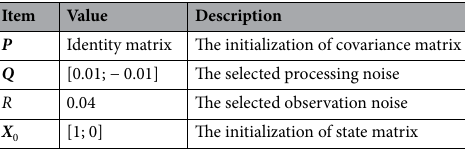
Table 4. The selected factors of filter algorithm for SOC estimation.